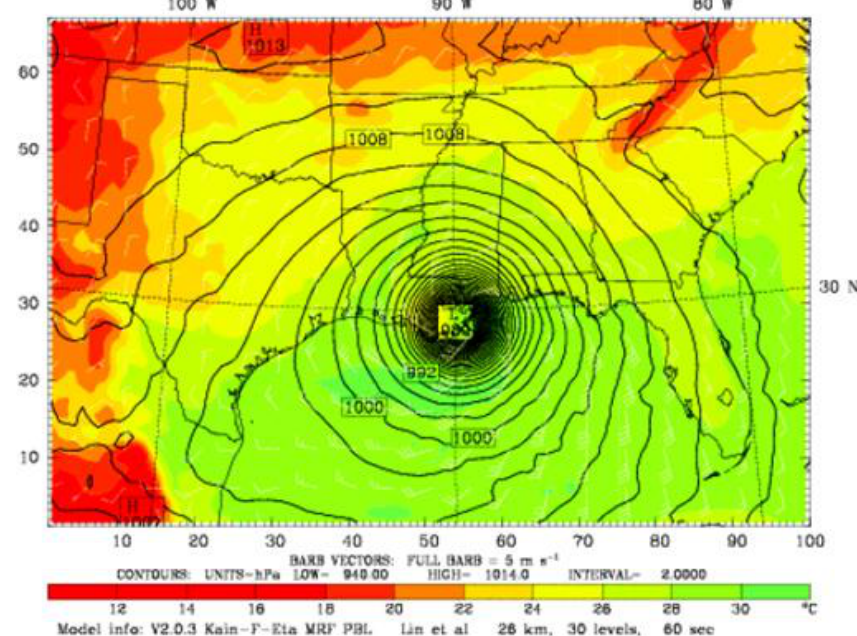
Figure 7. Modeling simulations of Sea Level Pressure on 28 August 2005 of 930 mb, at the time of Hurricane Katrina Land